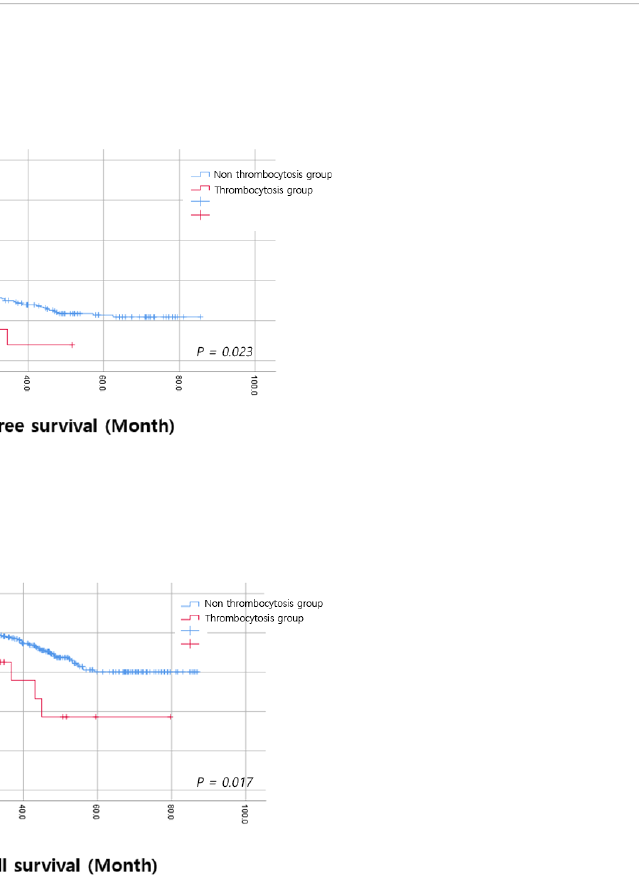
FIGURE 2 Kaplan – Meier analysis based on thrombocytosis at the fi fth cycle (A) Progression free survival. (B) Overall